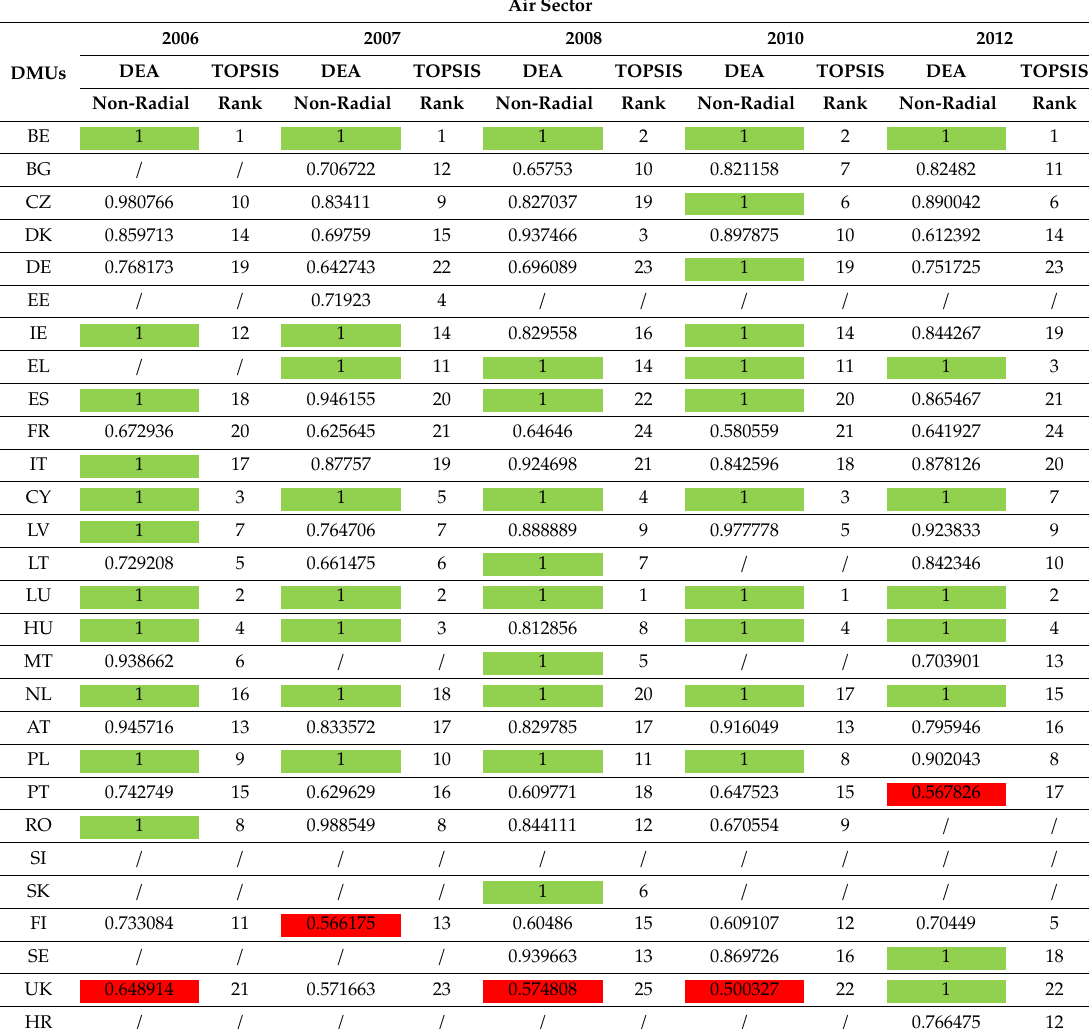
Green color: the best EEEI . Red color: the least EEEI